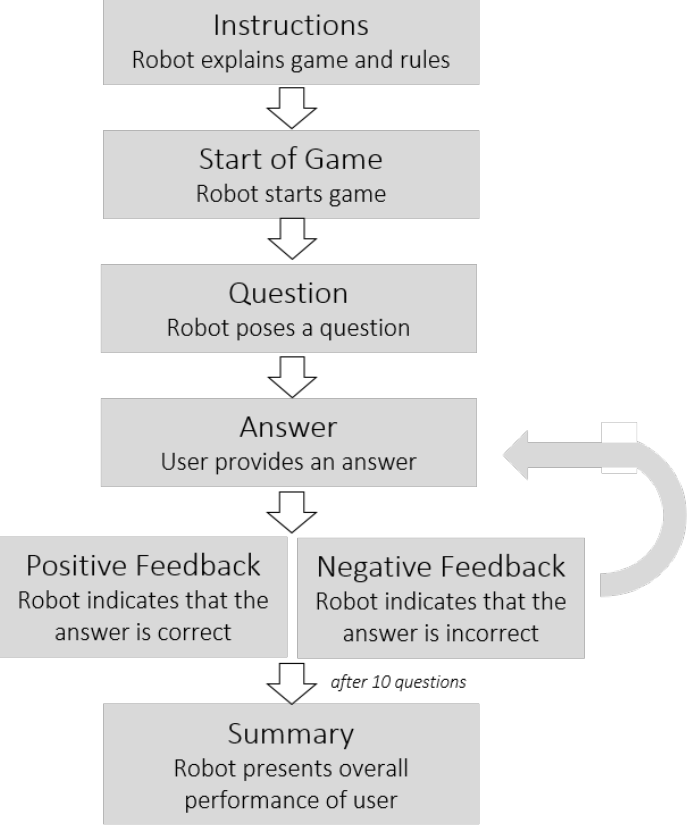
Figure 3. The phases of the quiz